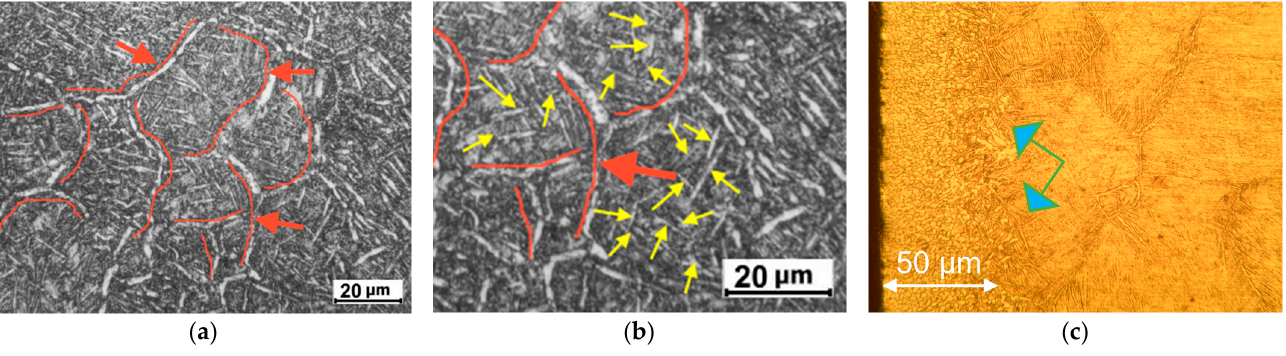
Figure 5. Microstructure of the BT22 alloy: ( a ) α phase on the boundaries of β grains, in the as-